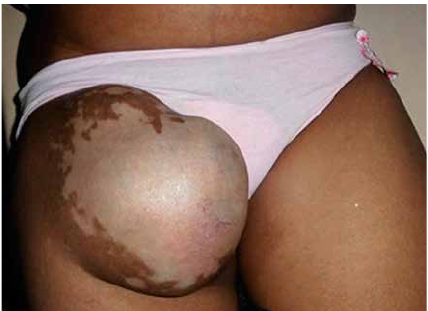
Figure 2: Achromic lesion with right inguinal swelling (archive of the Department of Dermatology, Joseph Raseta Befelatanana University Hospital, Antananarivo, Madagascar).